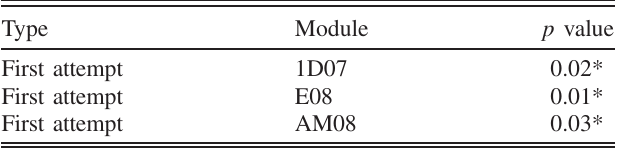
TABLE II. Modules for which a significant difference in the distribution of attempt duration was detected.